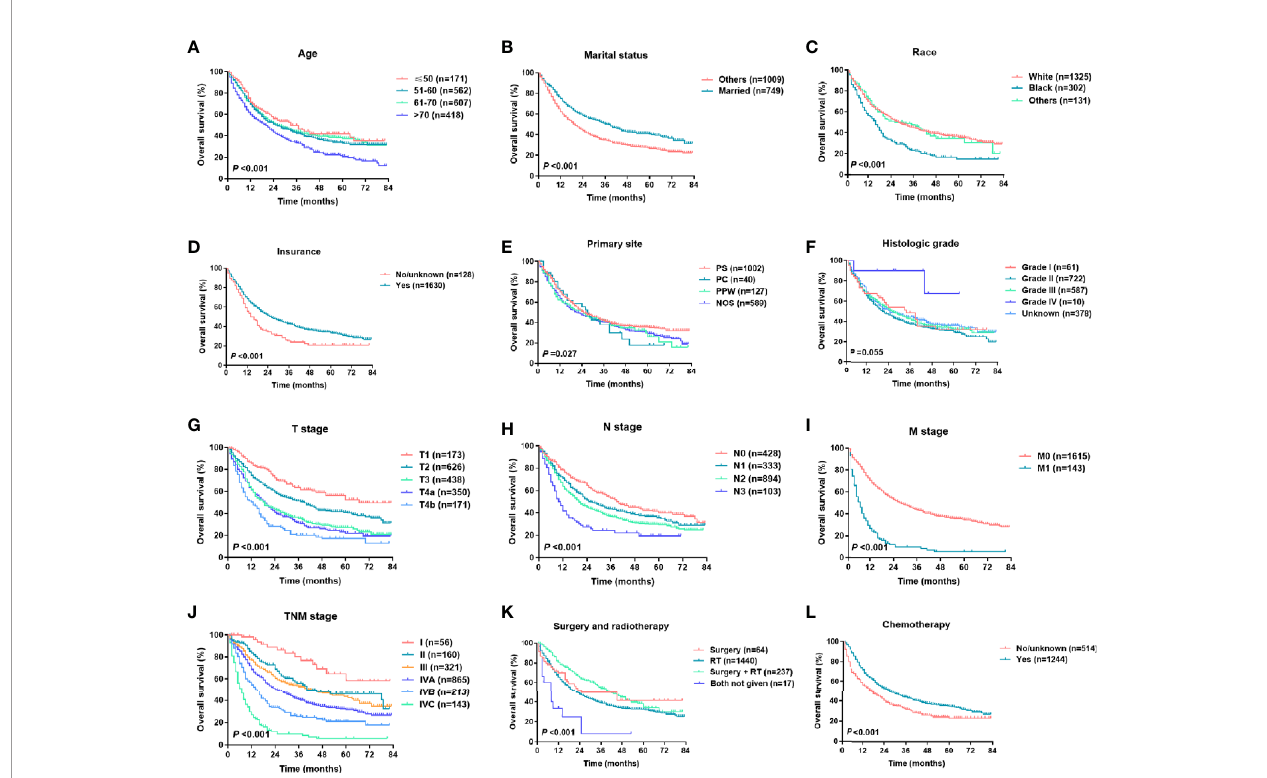
FIGURE 2 | Kaplan-Meier survival curves of HSCC patients in different subgroups: (A) age, (B) marital status, (C) race, (D) insurance status, (E) primary site, (F) histological grade, (G) T stage, (H) N stage, (I) M stage, (J) TNM stage, (K) surgery and radiotherapy, (L) chemotherapy.